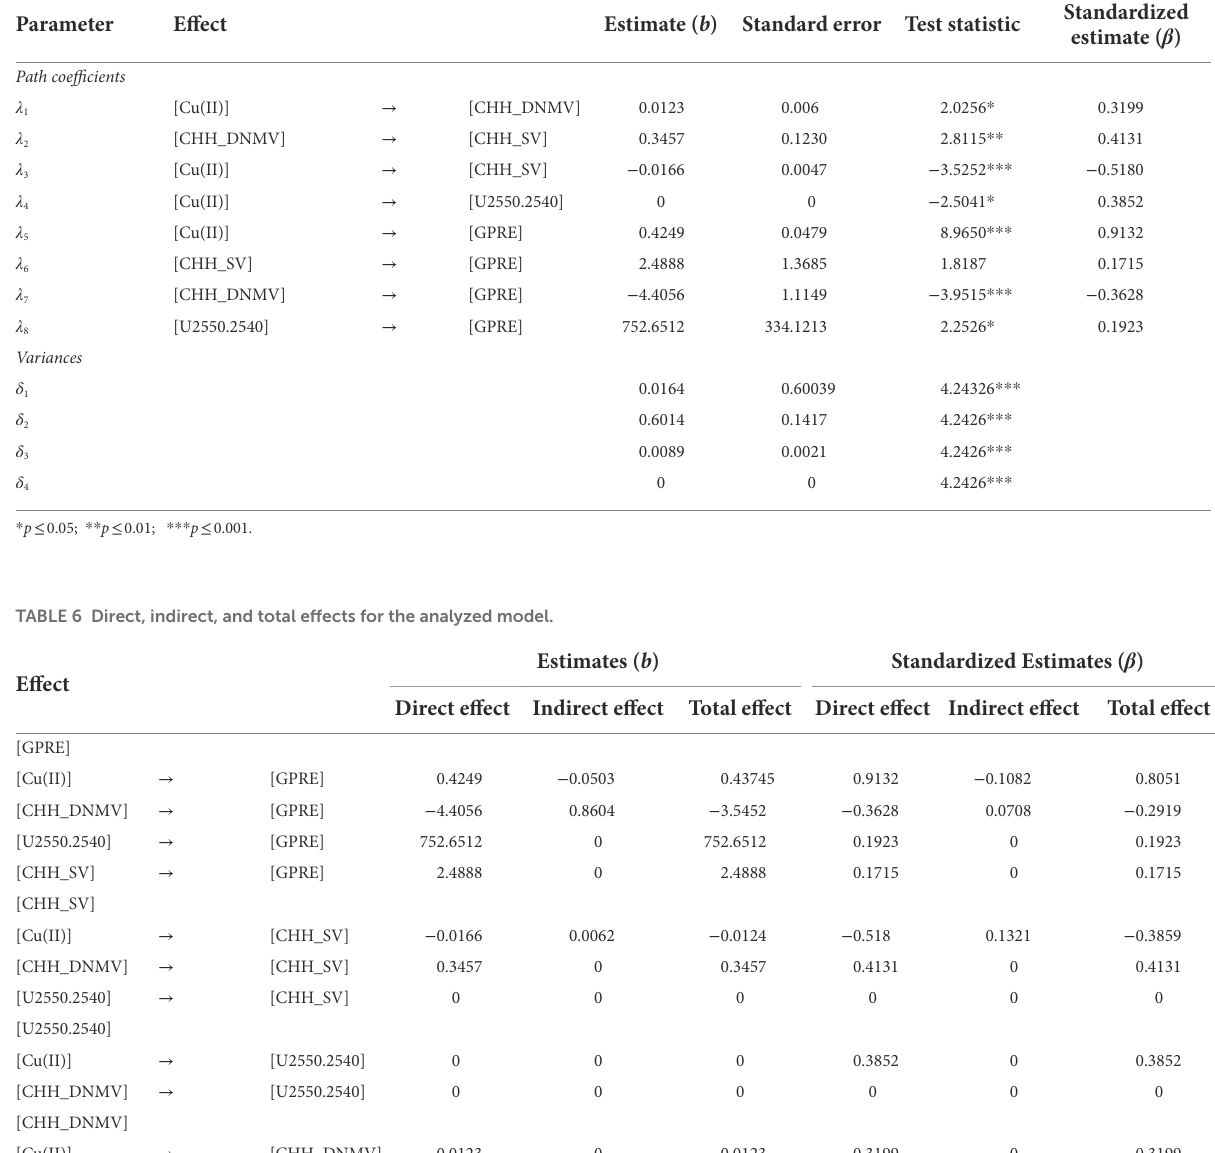
TABLE 5 Path coefficients, variances, and covariances for the analyzed model.